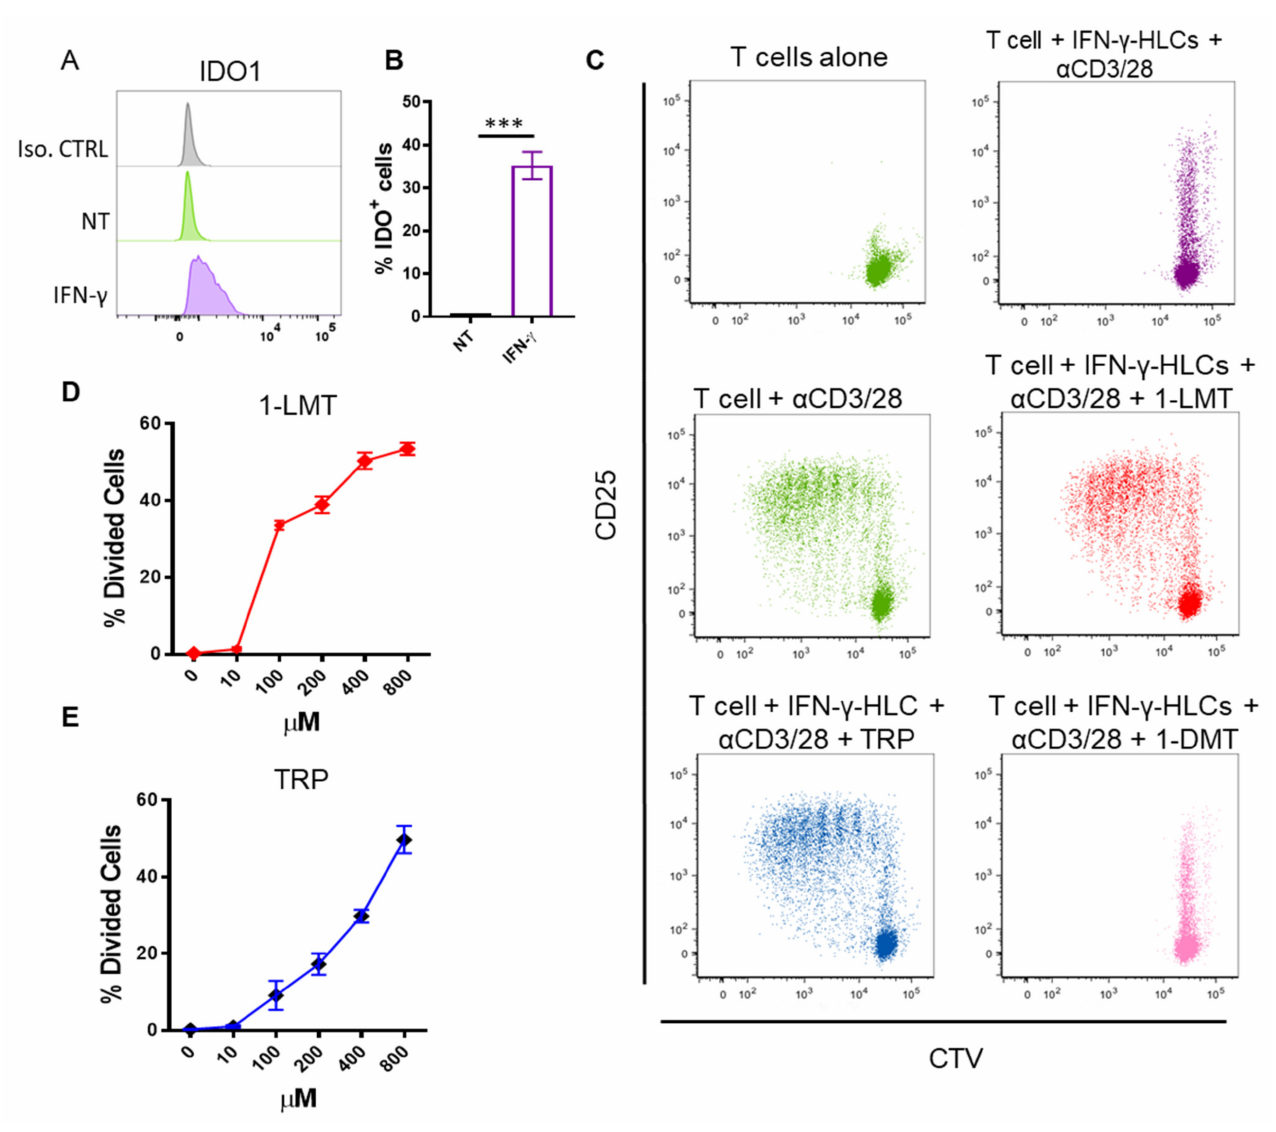
Figure 3. IDO1 expression in allogeneic HLCs suppress T cell proliferation by tryptophan starvation. ( A ) Representative histogram showing IDO1 expression in HLCs. In grey is isotype control, in green non-treated (NT) HLCs and in purple IFN- γ -treated HLCs. ( B ) Cumulative data showing the expression of IDO-1 in HLCs treated (median = 35.25 range = 4.5) or not with IFN- γ (median = 0.735, range = 0.013). ( C ) Representative dot plots of CellTrace Violet-labelled CD4 + T cells, co-cultured for 5 days with or without α CD3/CD28 beads (bead to cell ratio 1:40) in the absence (alone) or in the presence of IFN- γ -treated HLCs in the presence of 1-LMT, tryptophan or 1-DMT (200 µ M). Percentage of divided CD4 + T cells co-cultured with HLCs treated with IFN- γ in the presence of different doses of 1-LMT ( D ) and tryptophan (TRP) ( E ). Data are expressed as mean ± SD of 3 independent experiments with one donor per experiment *** p <